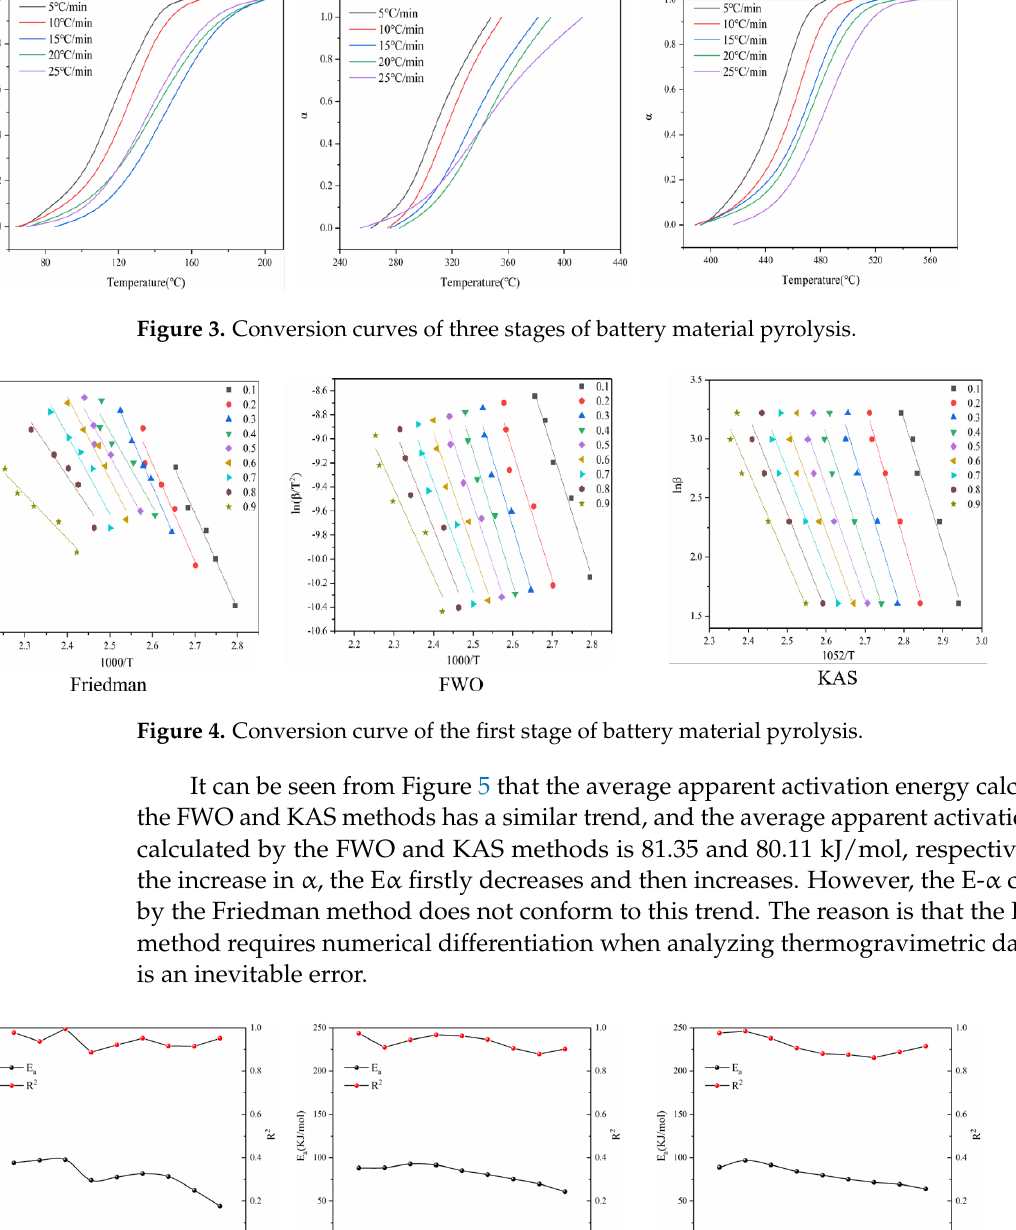
Table 1. Ea and R 2 of three model-free methods at different conversion rates in the first stage of pyrolysis kinetics of battery